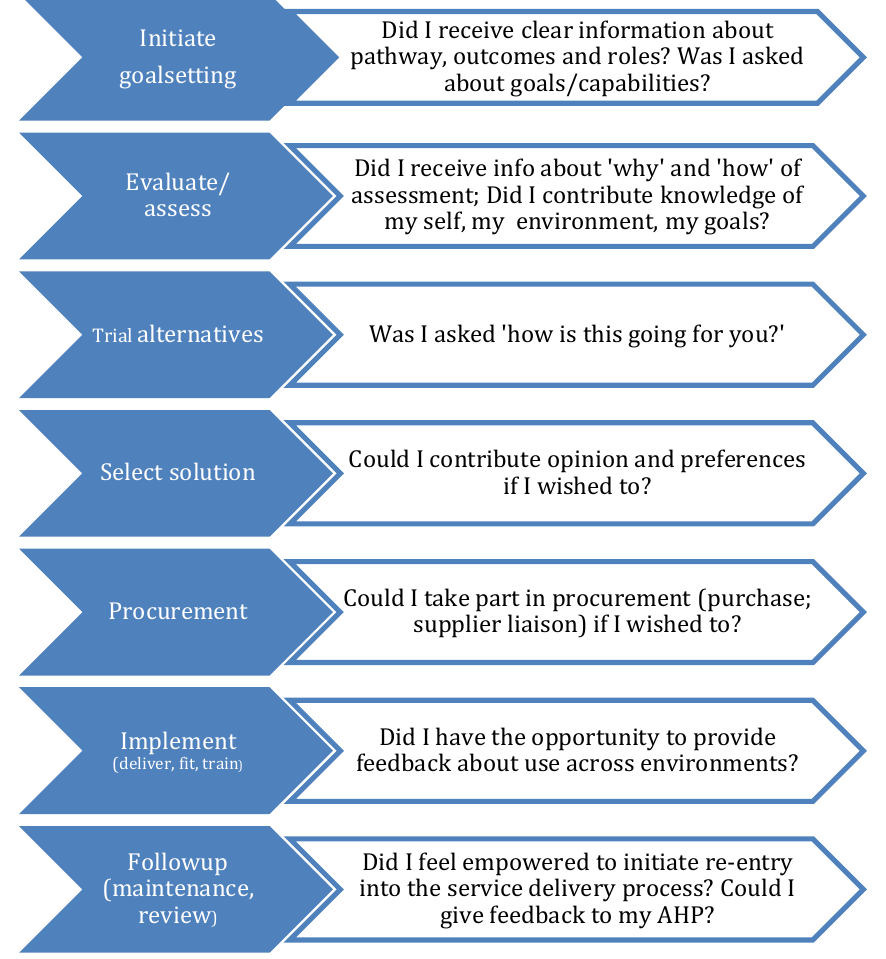
Figure 2. What AT users want from AT service delivery (adapted from de Jonge et al.)